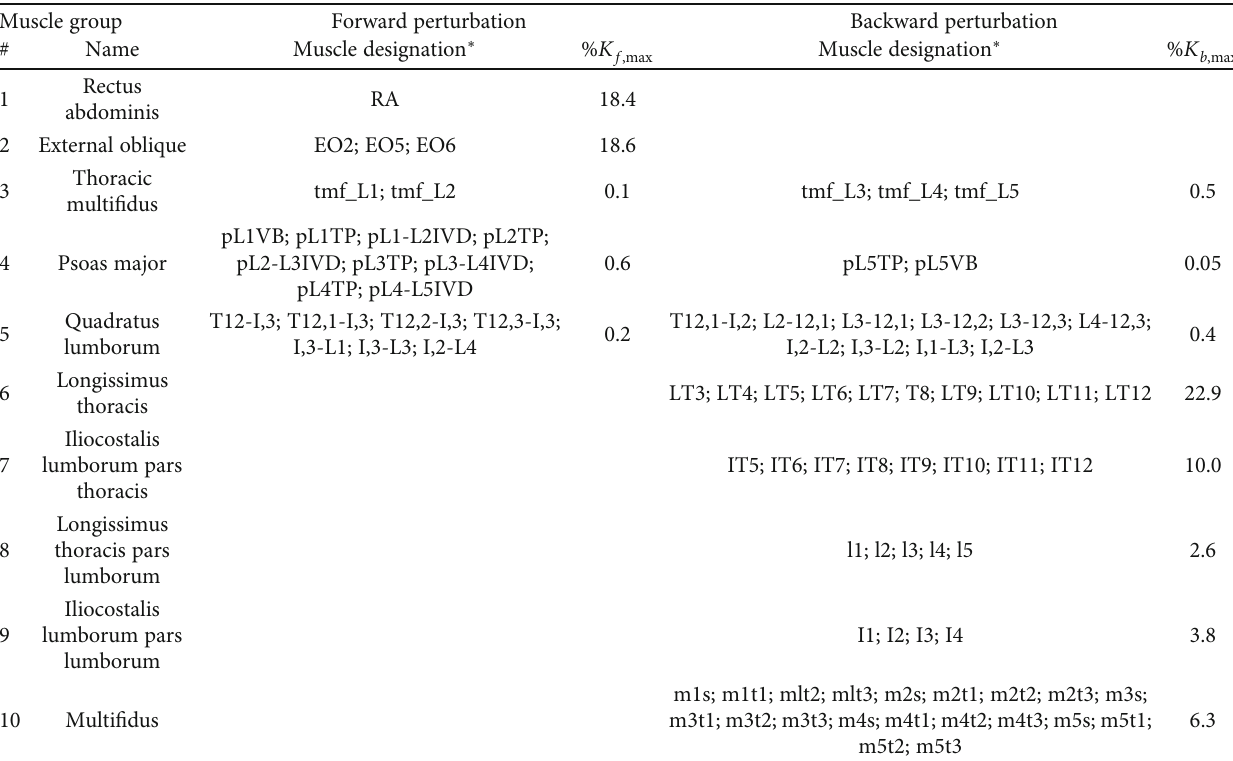
Table 2: Muscles shortened following forward and backward position perturbations and their contribution to the trunk sti ff ness. Muscle group